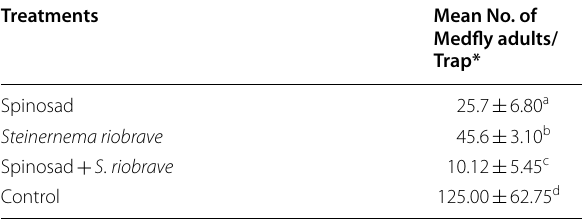
Table 3 Means of captured Medfly by traps baited in different treatments at ‘Succari’ orange